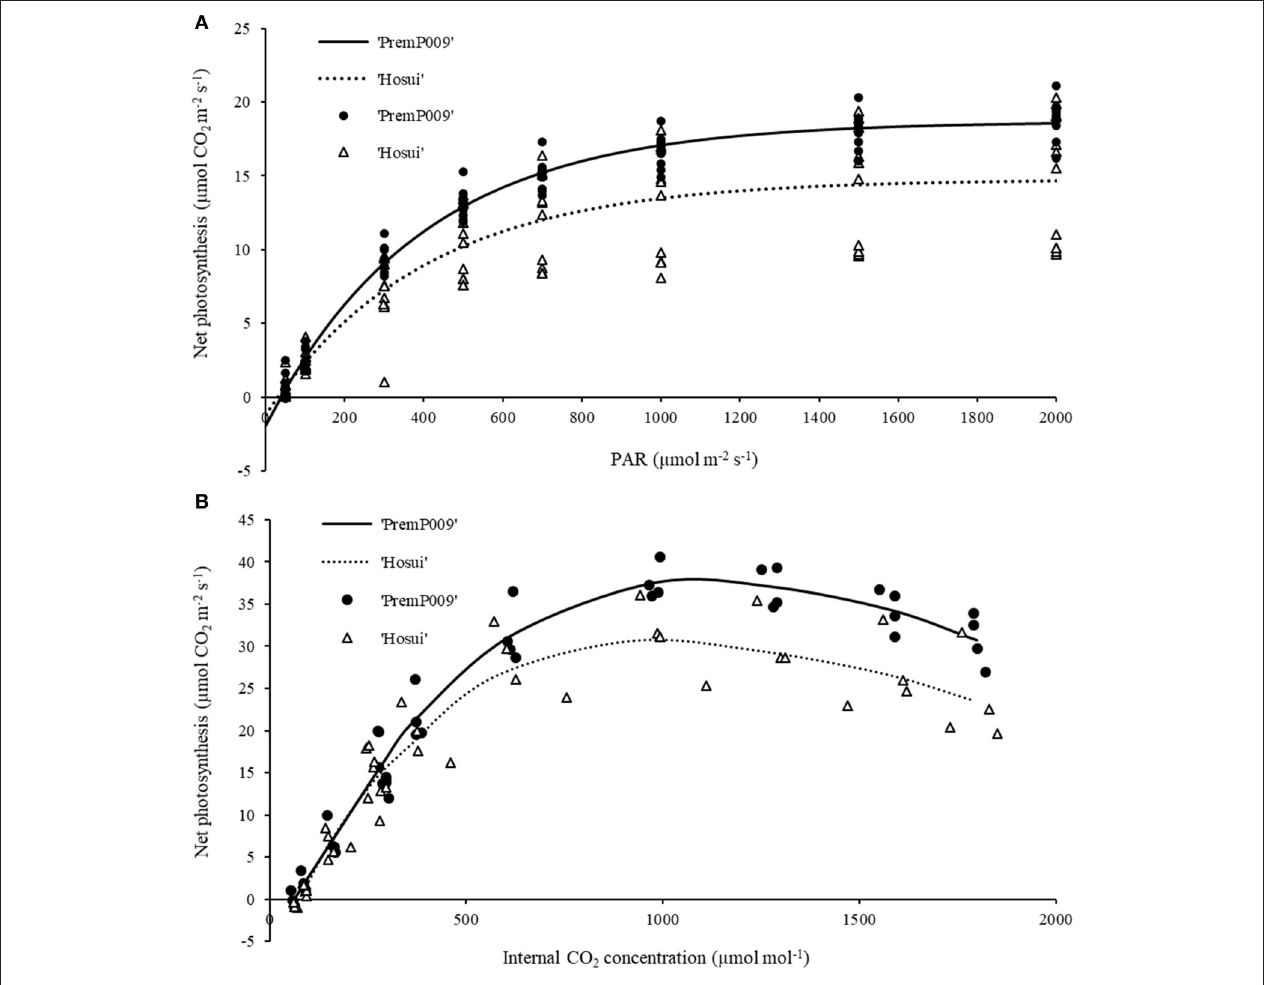
FIGURE 3 | Light response curve (A) at ambient CO 2 concentration (375 ppm) and carbon assimilation curve (B) at PAR 1,600 µ mol m − 2 s − 1 . Lines represent the fitted model and symbols denote real data. Each curve represents the average of 4–6 leaf replicates of mixed (M) trees.